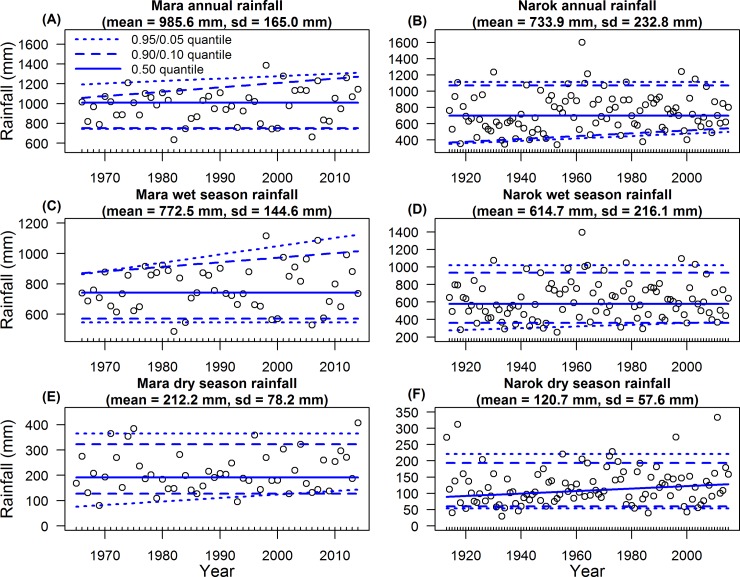
Temporal trends in the severity of droughts and floods.Blue lines are the 0.95/0.05 (dotted), 0.90/0.10 (dashed) and 0.50 (continuous) quantiles. (A, C, E) Rainfall recordings in the Mara were derived from 15 gauges (Eq 3 in S1 Text) during 1966–2014 (dry season: 1965–2014). (B, D, F) Rainfall in Narok Town in Kenya was recorded during 1914–2015 (dry season: 1913–2015). The (A, B) annual, (C, D) wet season and (E, F) dry season rainfall components (points) were summed from the monthly rainfall records.